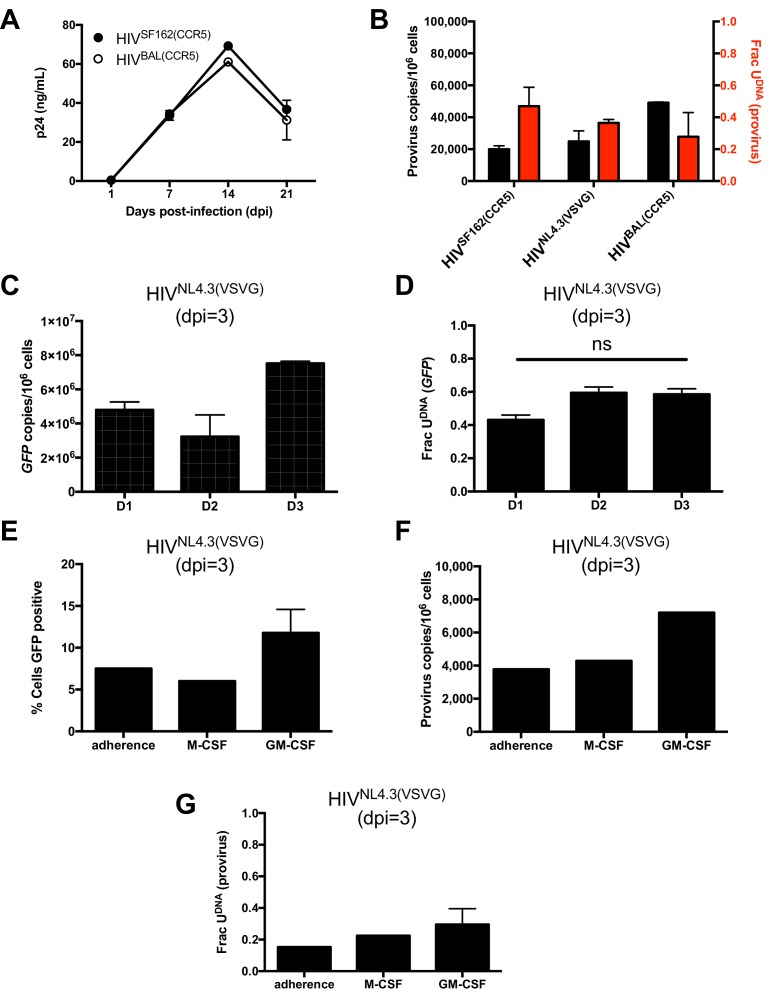
Three different viral strains show a similar uracilation profile with in vitro infected MDMs independent of the differentiation regimen.(A) The kinetics and absolute levels of virus output as measured by p24 ELISA is indistinguishable for MDMs infected with HIVSF162(CCR5) and HIVBAL(CCR5). (B) Provirus copy number and uracil content at dpi = 3 are very similar in MDMs infected with HIVSF162(CCR5), HIVNL4.3(VSVG) or HIVBAL(CCR5) (MOI = 0.1). Proviral copy numbers were measured using ALU-gag nested qPCR and the uracil content by Ex ALU-gag nested qPCR. (C) Infection of MDMs obtained from peripheral blood monocytes of three donors produces equivalent levels of uracilated HIVNL4.3(VSVG) DNA as judged by ddPCR analysis of the GFP copies. (D) The fraction of viral GFP copies that contain uracil is similar for all three donors as determined using Ex-ddPCR (ns; not significant). (E) Purified monocytes isolated from bulk PBMCs were differentiated to MDMs in vitro using the adherence method, or by addition of M-CSF or GM-CSF. The differentiation regimen did not significantly affect viral GFP expression in MDMs infected with HIVNL4.3(VSVG), or (F) proviral DNA copy number as determined by ALU-gag nested qPCR, or (G) the fraction of viral DNA copies that contained uracil as determined by Ex ALU-gag nested qPCR. Number of experimental replicates (n = 2–3) and errors are reported as mean ± SD.